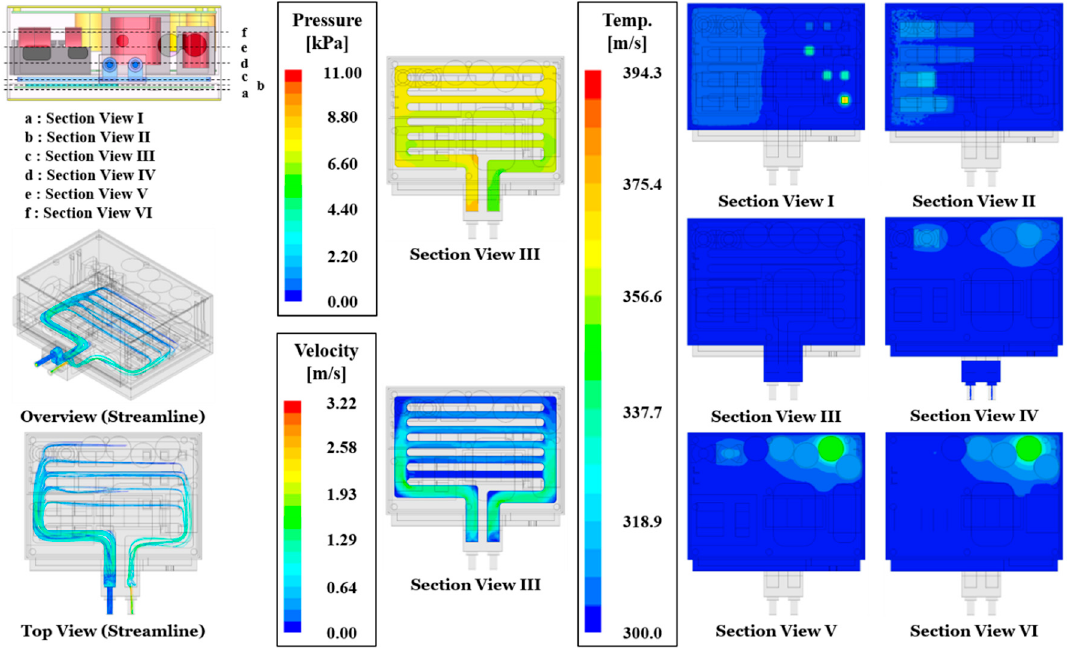
Figure 14. Streamline, pressure, velocity, and temperature distribution in the integrated module for a cooling water flow rate of 6 LPM over a time period of 4000 s in Operating Mode 4.